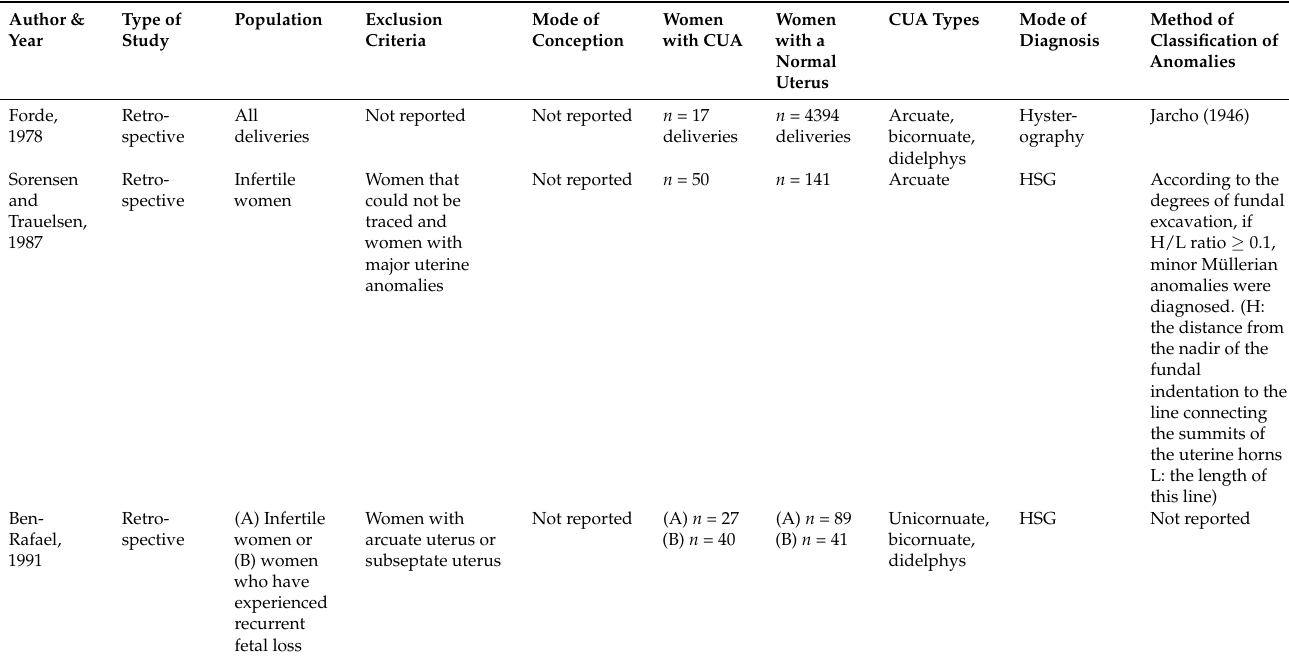
Figure 1. Flow diagram of the study selection process. Table 1. Characteristics of included